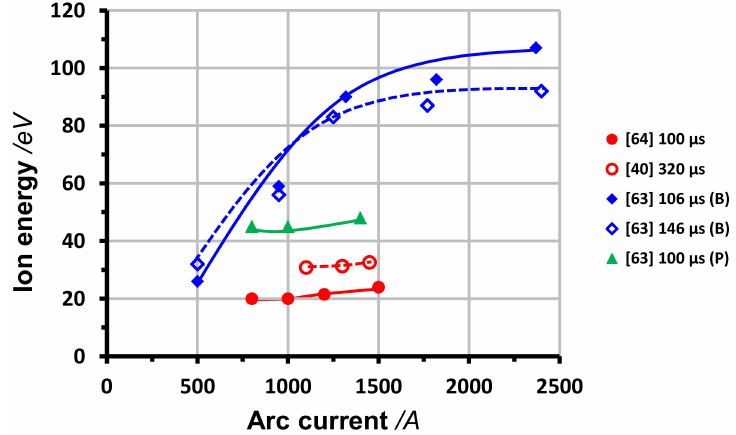
Figure 8. Energy of the carbon ions, measured against ground, vs. arc current maximum for Laser-Arc depositions. Cathodic Laser-Arc [63] with different coating units (B, P), anodic Laser-Arc [64] and filtered anodic Laser-Arc